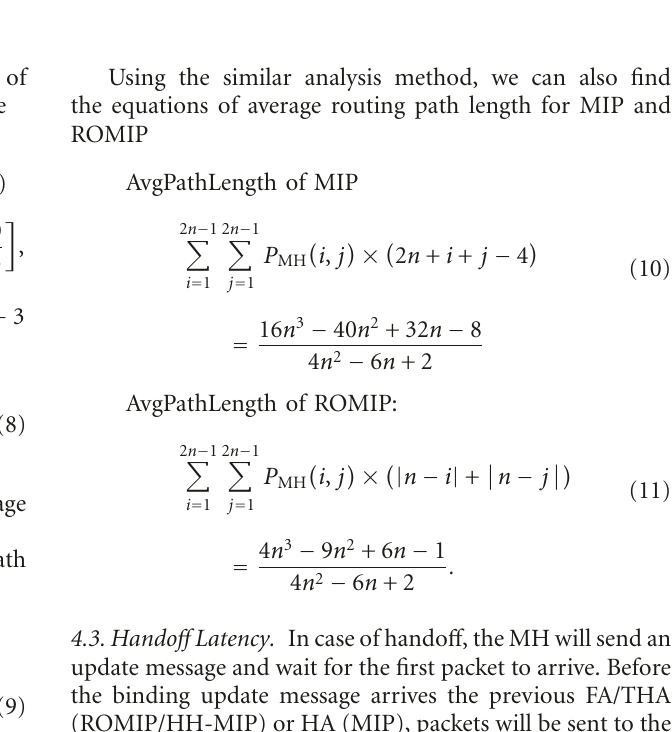
Figure 6: Di ff erent location cases used for routing path analysis in